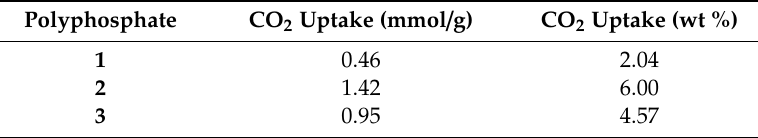
Table 4. CO 2 adsorption capacities of 1 – 3 at 323 K and 40